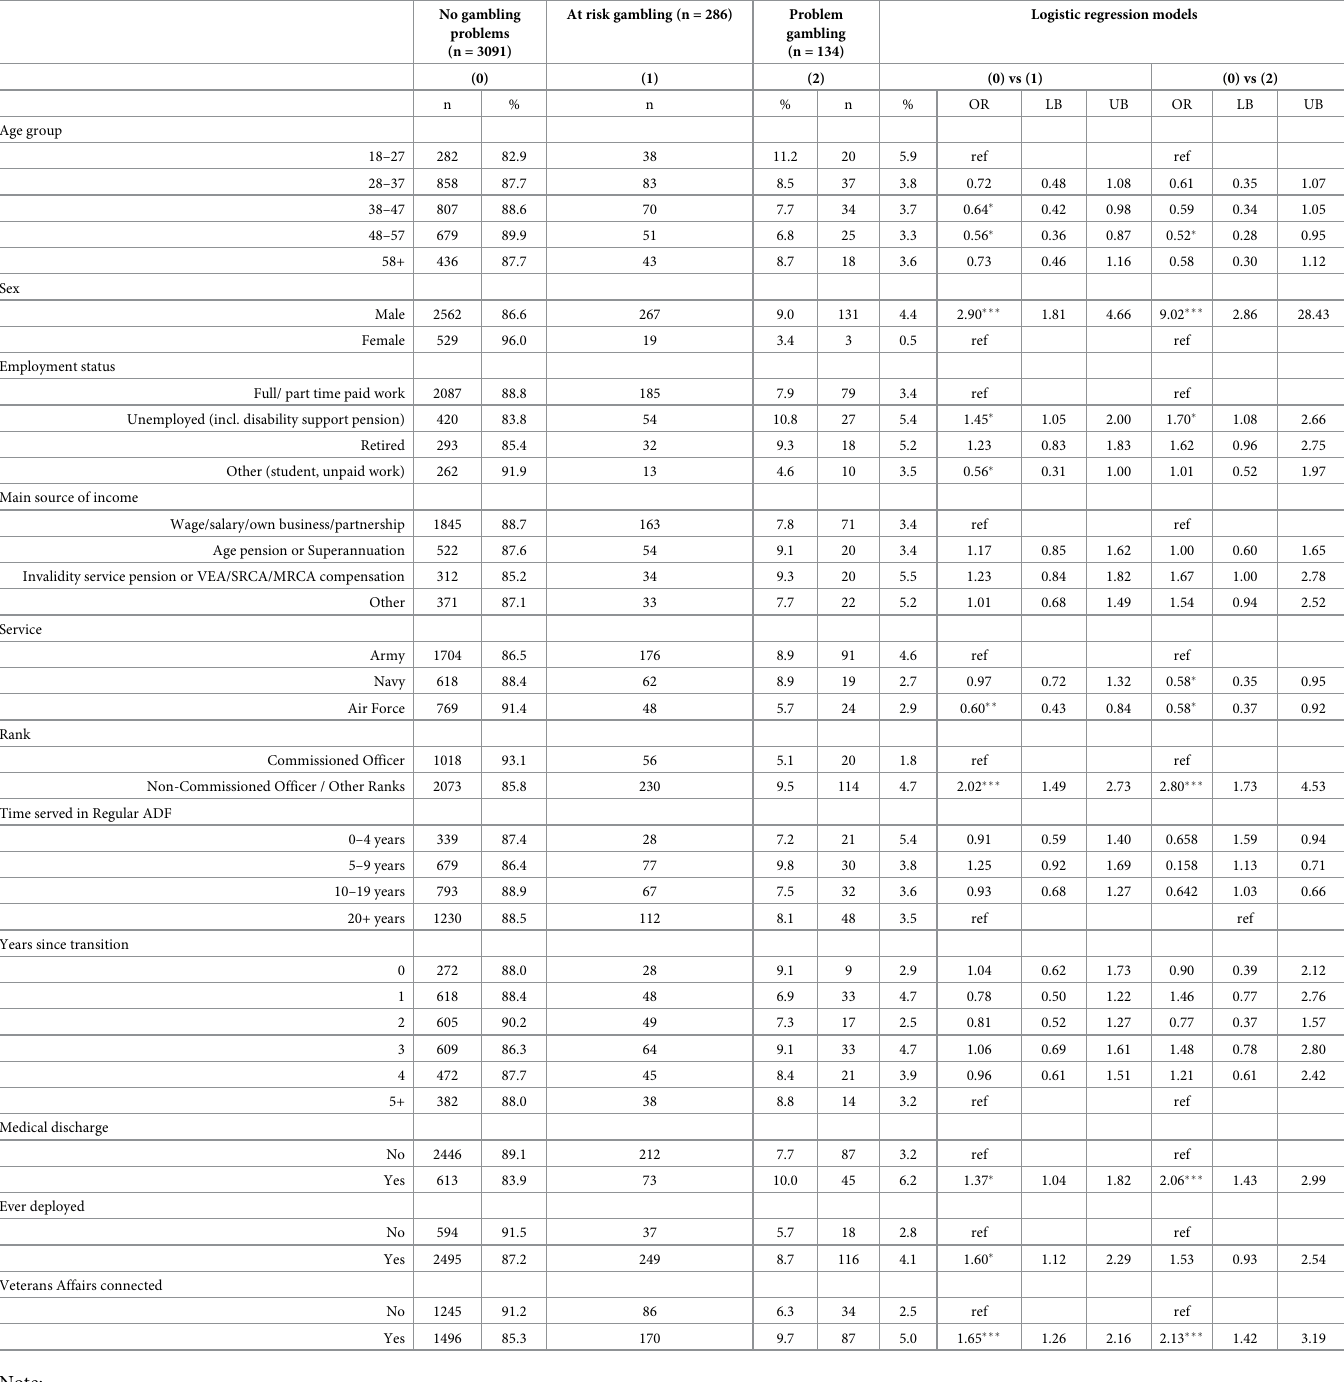
Table 2. Multinomial logistic regression models indicating socio-demographic predictors of at risk and problem gambling.